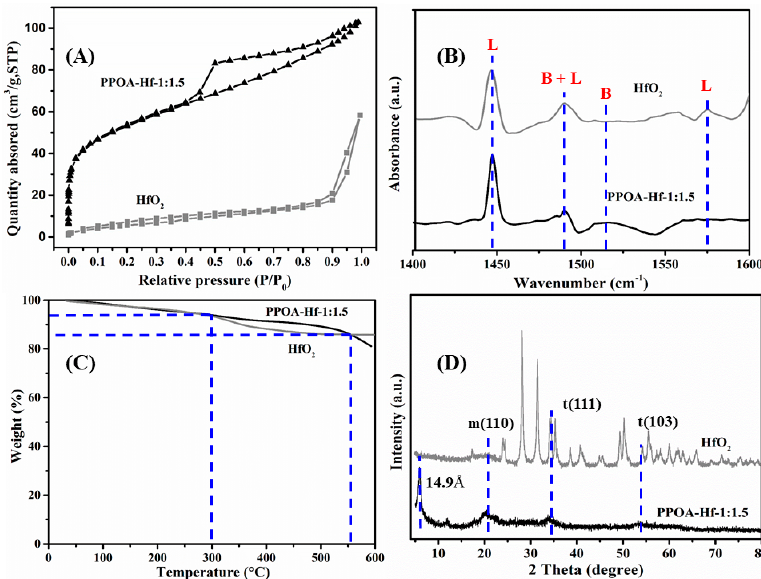
Figure 1. N 2 adsorption–desorption isotherms ( A ); pyridine-adsorbed infrared (IR) spectra ( B ); thermogravimetry (TG) curves ( C ); and X-ray diffraction (XRD) patterns ( D ) of HfO 2 and the phosphonate–hafnium solid catalyst (PPOA–Hf-1:1.5); L = Lewis acid; B = Brønsted